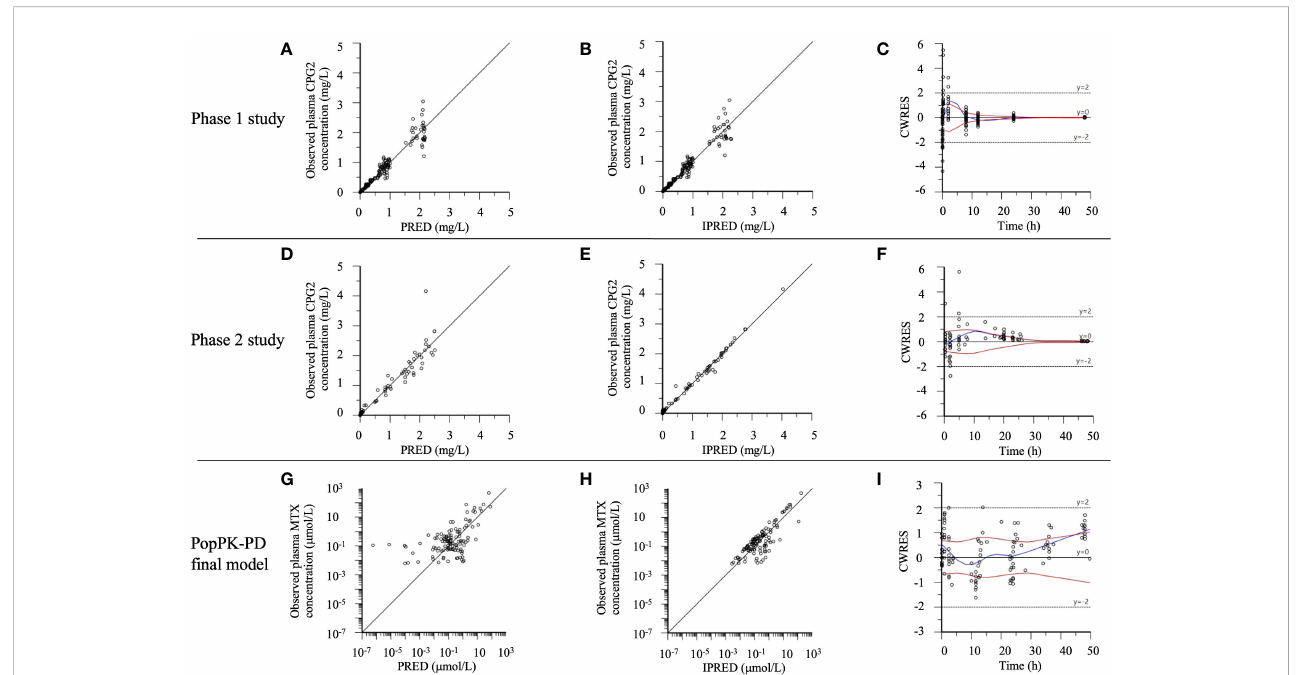
FIGURE 4 The phase 1 and 2 study CPG2, CPG2-MTX popPK-PD fi nal model goodness-of- fi t plots. (A – C) Phase 1 study CPG2 fi nal model. (D – F) Phase 2 study CPG2 fi nal model. (G – I) CPG2-MTX popPK-PD fi nal model. (A, D) Observed plasma CPG2 concentrations versus PRED (predicted plasma CPG2 concentrations). (B, E) Observed plasma CPG2 concentrations versus IPRED (individual predicted plasma CPG2 concentration). (C, F, I) CWRES (conditional weighted residuals) versus time. (G) Observed plasma MTX concentrations (logarithmic scale) versus PRED. (H) Observed plasma MTX concentrations (logarithmic scale) versus